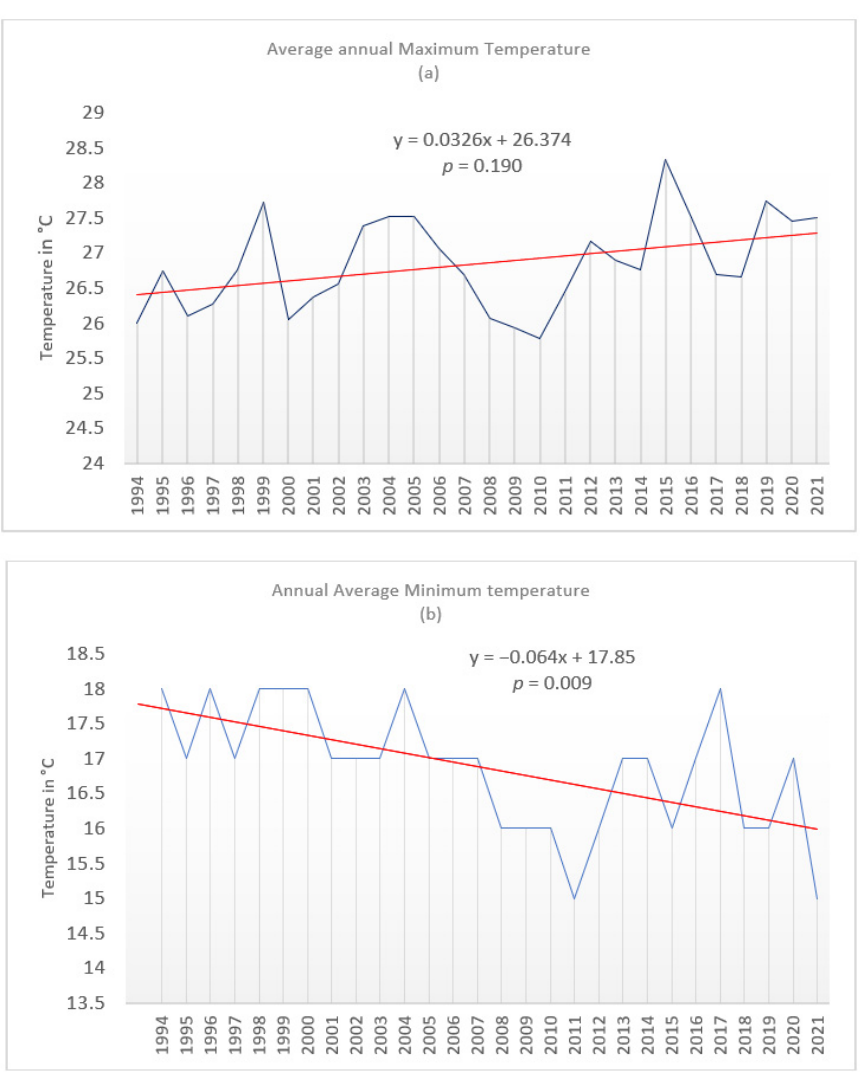
Figure 3. Annual average maximum and minimum temperatures for Mbazwana 1994–2021. Source: Authors.